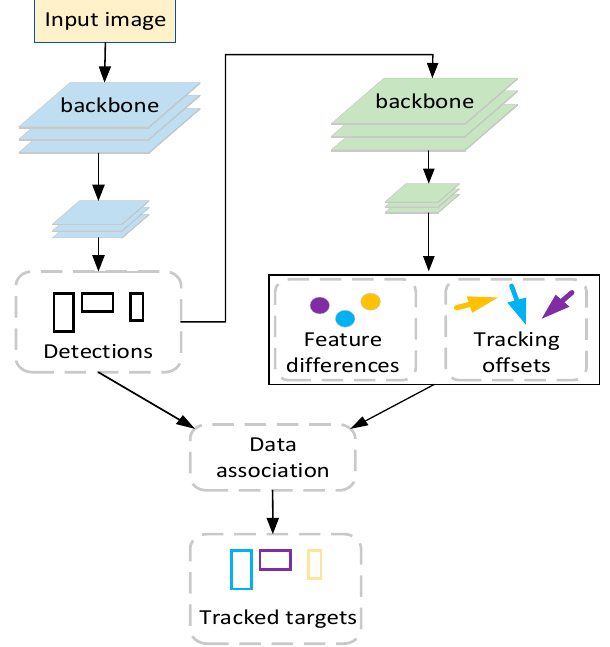
Figure 1. Flowchart of online tracking-by-detection.